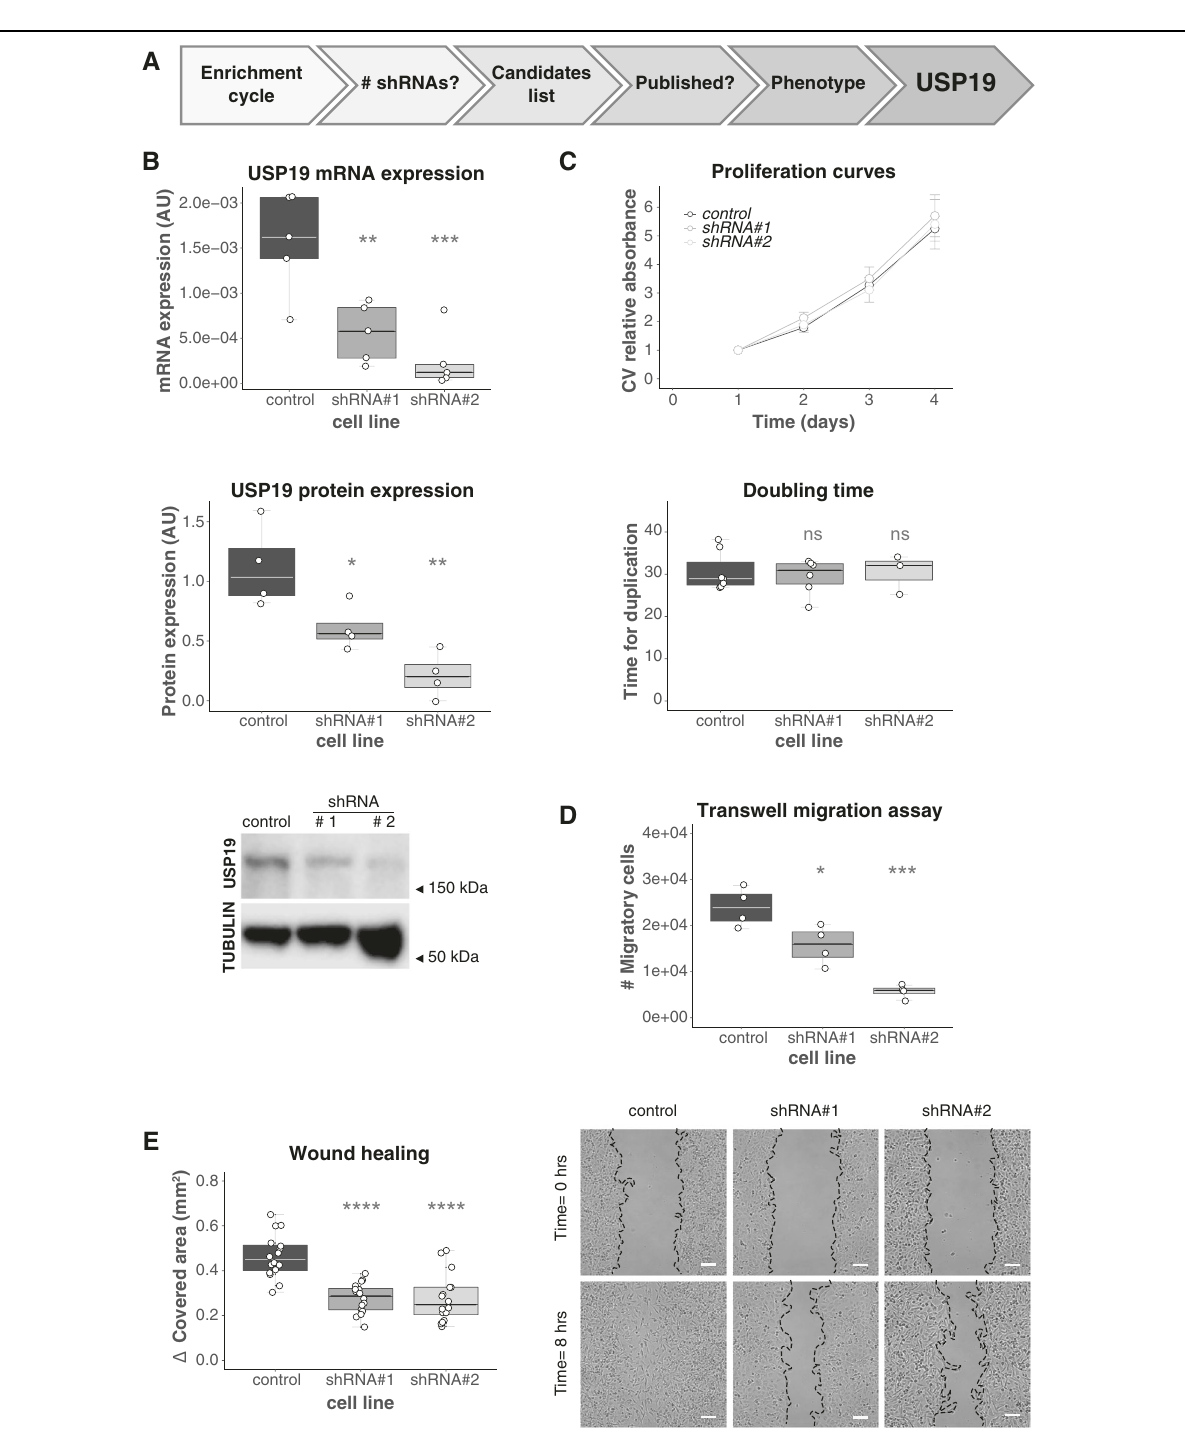
After the selection process, we followed an analytical work fl ow to select candidate genes for further validation (Fig. 2A). In order to avoid false positives due to